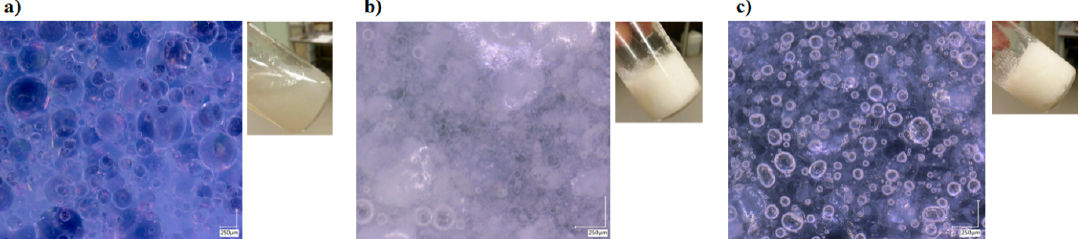
Figure 1. Micrographs of ( a ) pickering emulsion, ( b ) bigel, and ( c ) NPs bigel.